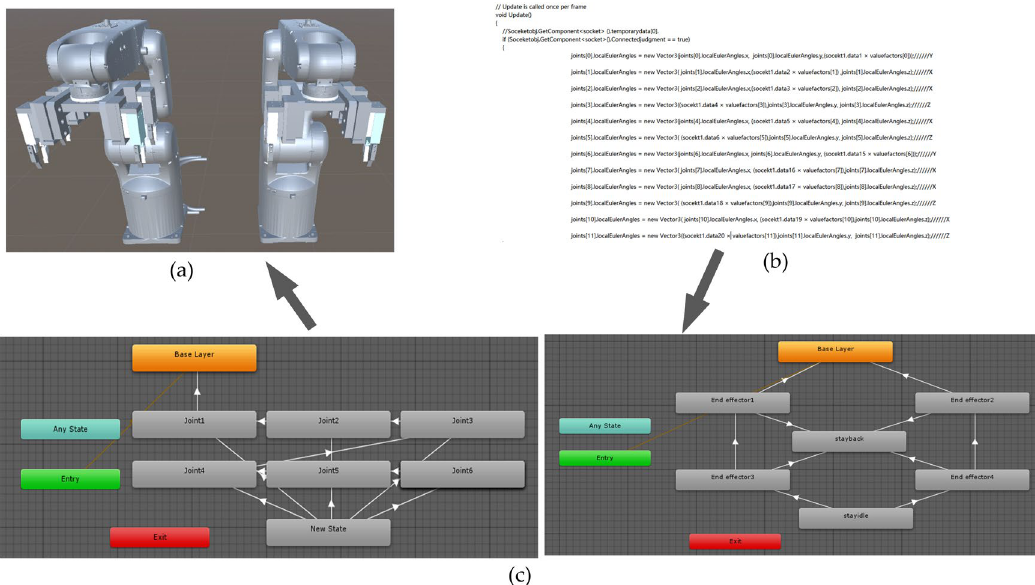
Figure 20. Kinematic control algorithm for robot model: ( a ) Digital twin model; ( b ) Kinematic algorithm; ( c ) Animator control.